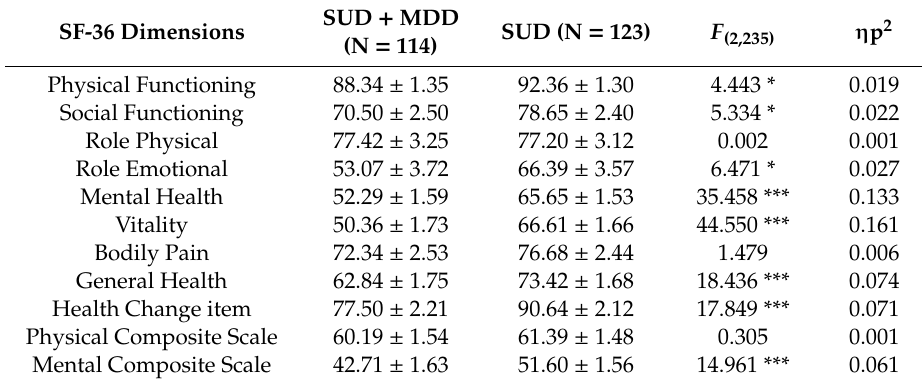
Table 3. Health-related quality of life results according to the diagnosis. First multivariate analyses of covariance (MANCOVA) analysis with descriptive statistics (mean and standard error), normative data, F, and eta square ( η p 2 ) tests.